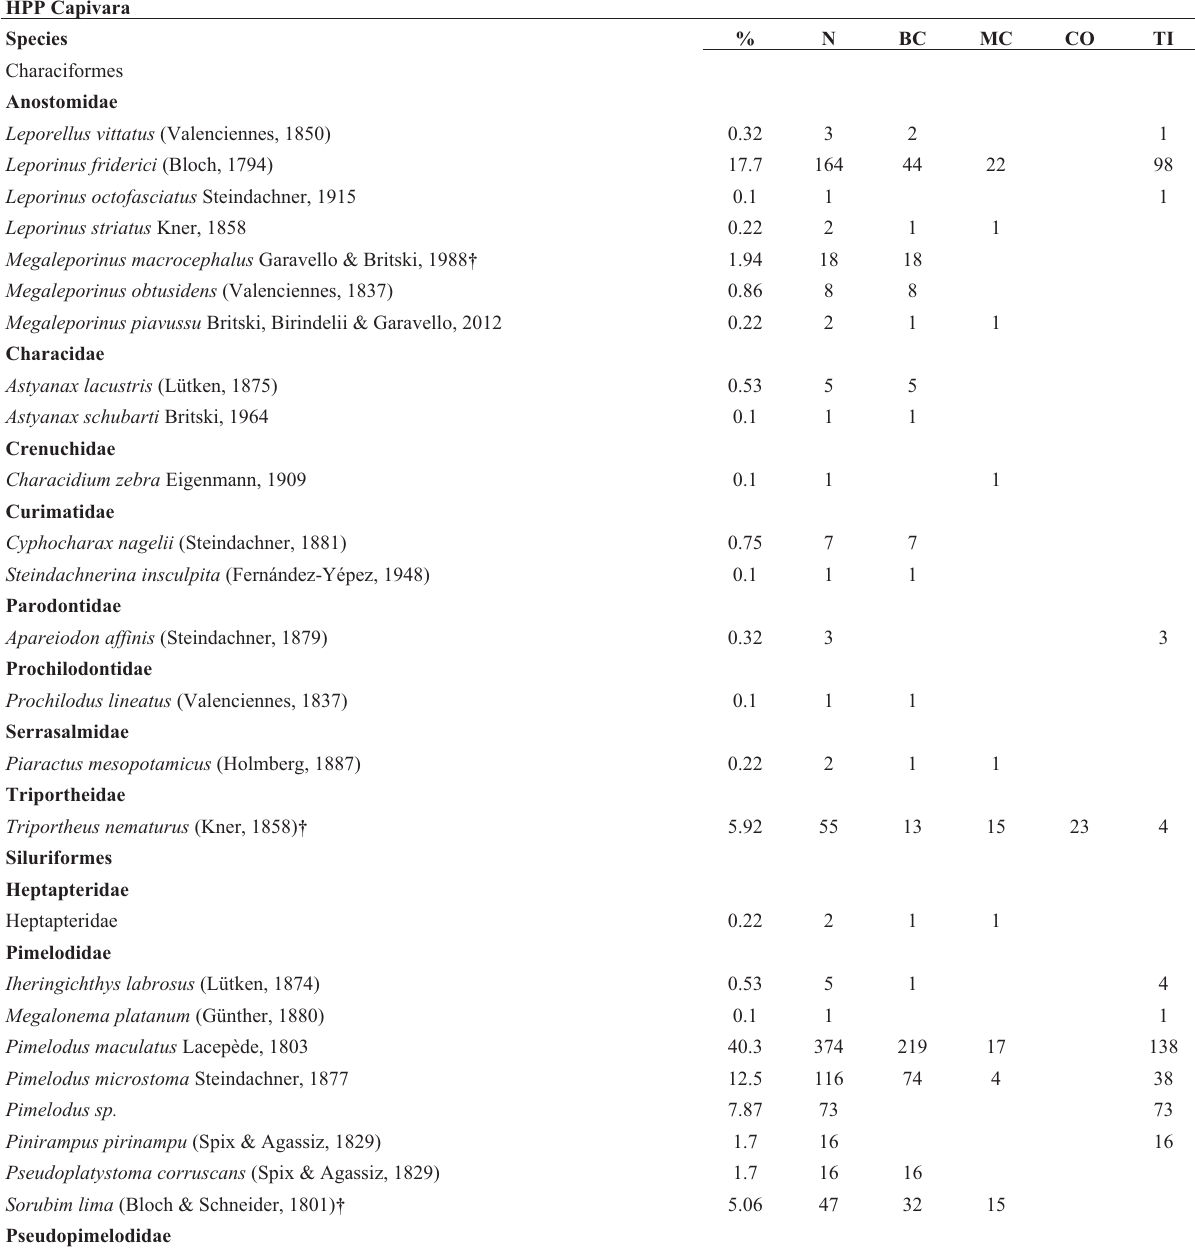
Table 1 - Table of species distribution in the Capivara reservoir